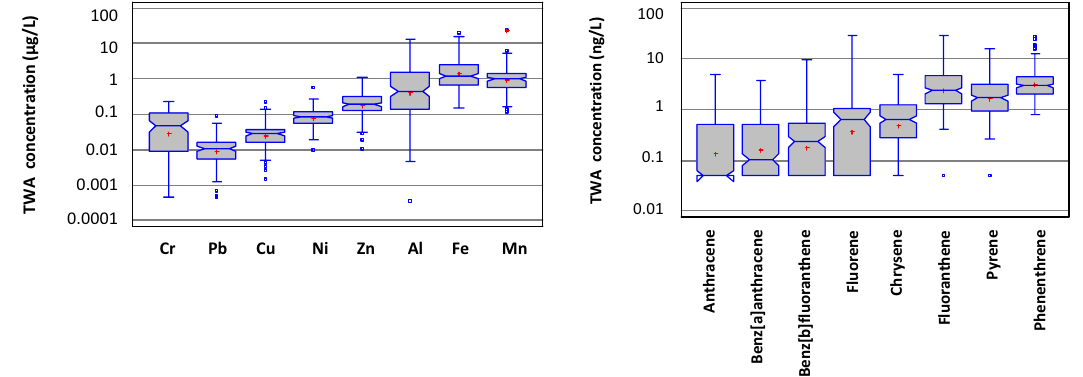
tively represented by a horizontal line and a red + sign inside the box. The box notch corresponds to the error associated with the